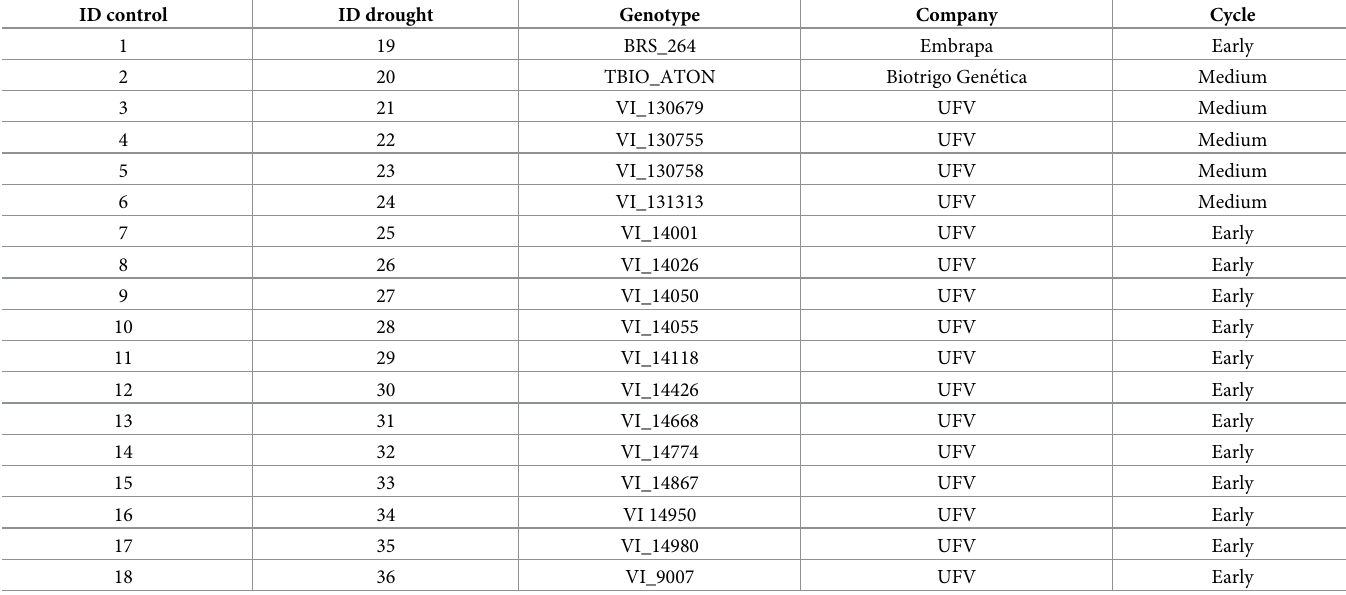
Table 1. Wheat genotypes (two cultivars and 16 strains in a crop value and use (VCU) assay of the UFV Wheat Program) submitted to control condition and drought